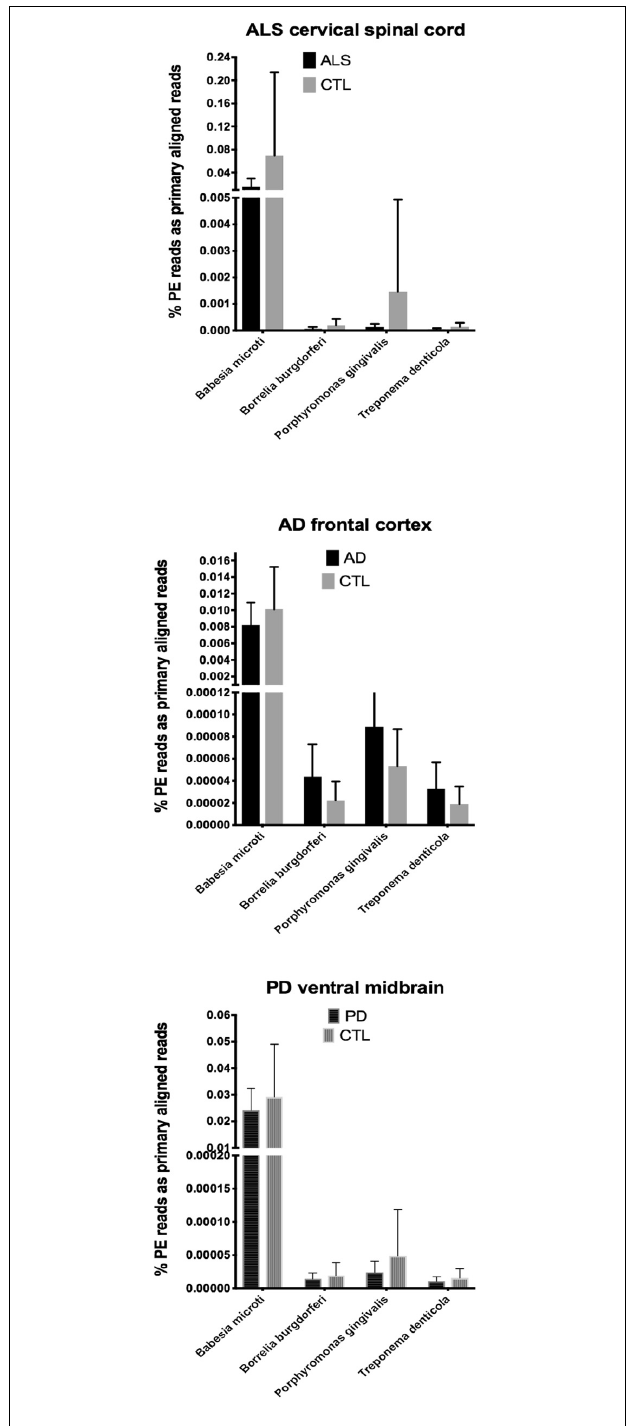
FIGURE 2 | Bar charts of % of total PE reads that aligned in Bowtie2 to the genomes of Toxoplasmosis gondii and Trichinella sp. T6. Shown are mean % +SD.